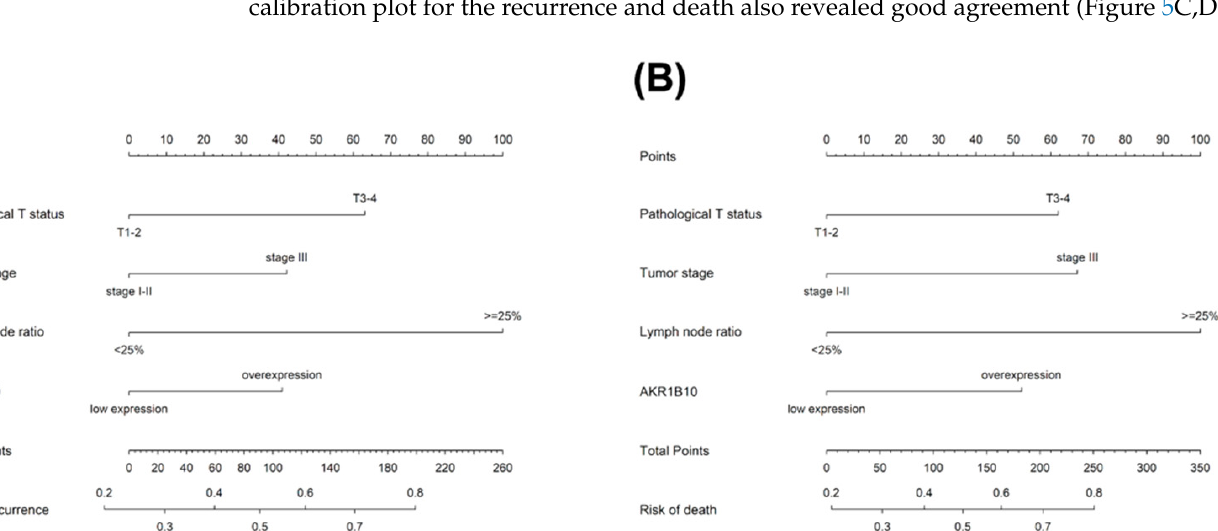
Figure 3. Comparison of Kaplan–Meier curves of 5-year DFS and OS rates between GC patients with overexpression and low expression of AKR1B10. Adjuvant chemotherapy subgroup: ( A ) DFS and ( B ) OS; signet ring cell carcinoma subgroup: ( C ) DFS and ( D ) OS; pathological stage I subgroup: ( E ) DFS and ( F ) OS.